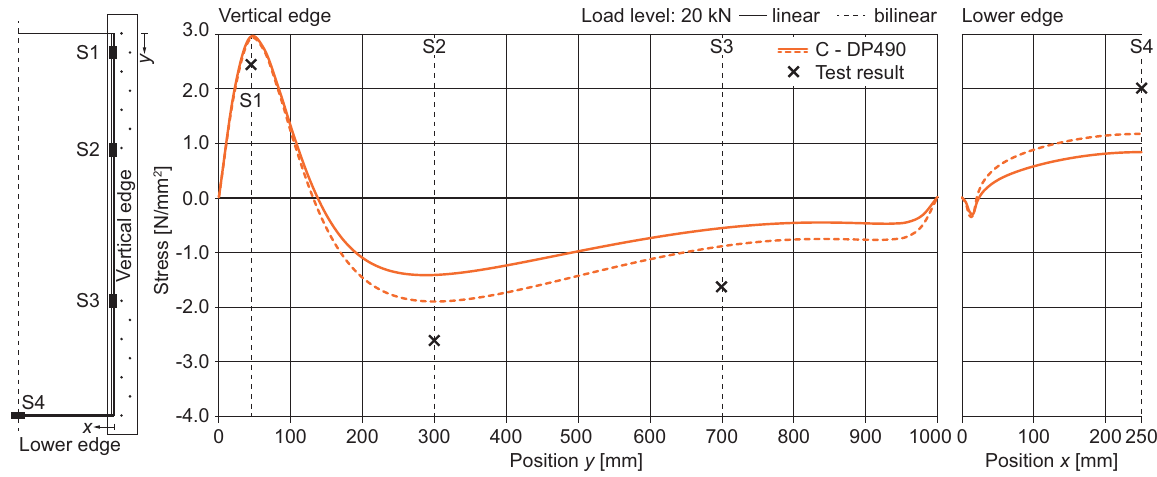
Fig. 15 Calculated stresses along the vertical and the lower horizontal glass edge for C - Scotch-Weld DP490 compared to measured values at the strain gauge positions